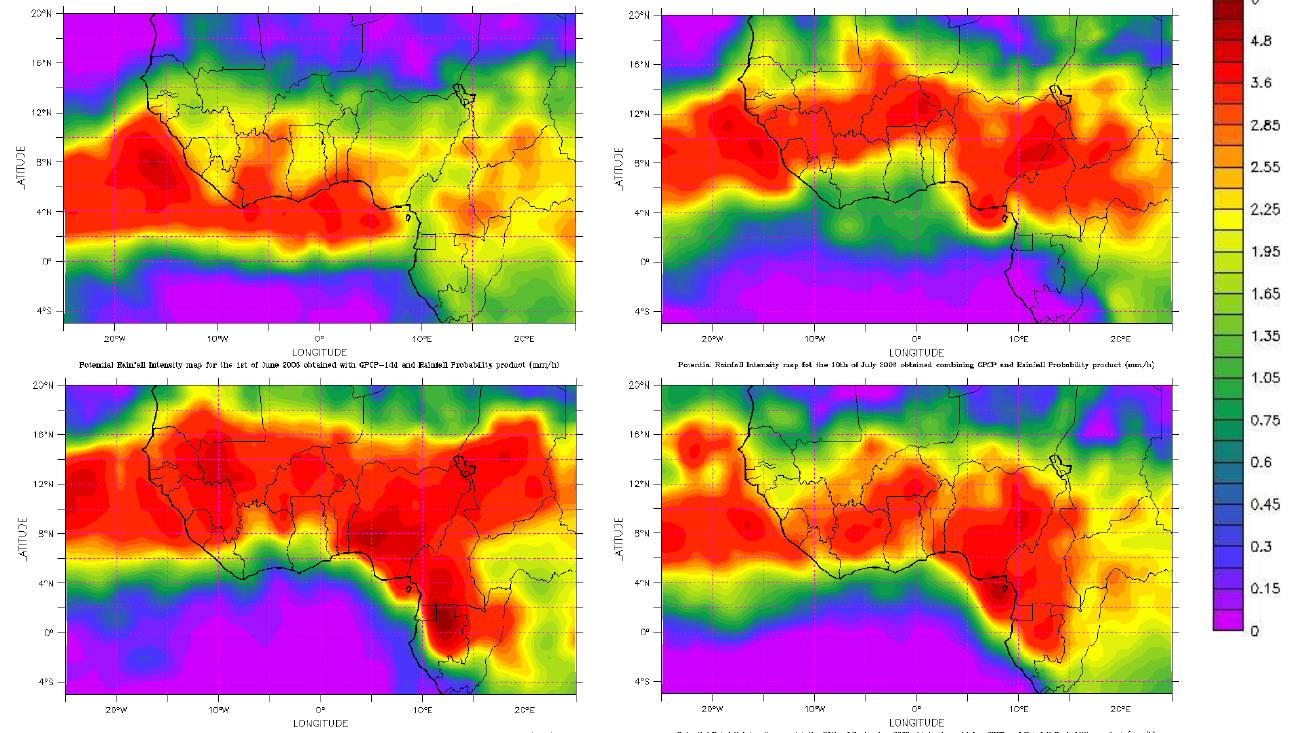
Fig. 10. EPSAT-SG daily rainfall potential